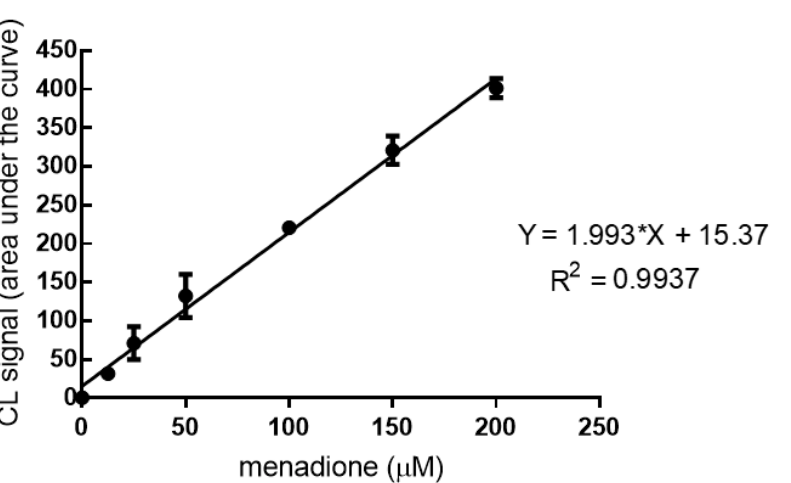
Figure 3. Chemiluminescence kinetic profiles obtained for human HaCat spheroids in the presence of the dioxetane CL probe and different concentrations of menadione (range: 5–200 µ M). A good correlation between the CL signal and the concentration of menadione was observed, which reflects the physiological mechanisms of intracellular H 2 O 2 production. The concentrations of the pro-oxidant agent menadione required to obtain a detectable increase in the CL signal were in the micromolar range (LOD and LOQ were 6.3 µ M and 8.0 µ M,